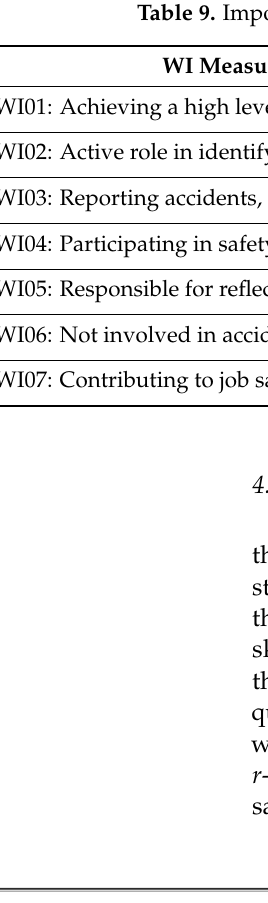
Table 8. Importance of ComP Measurements in Model 3 (Adopted from Mohamed, 2002 [8]).